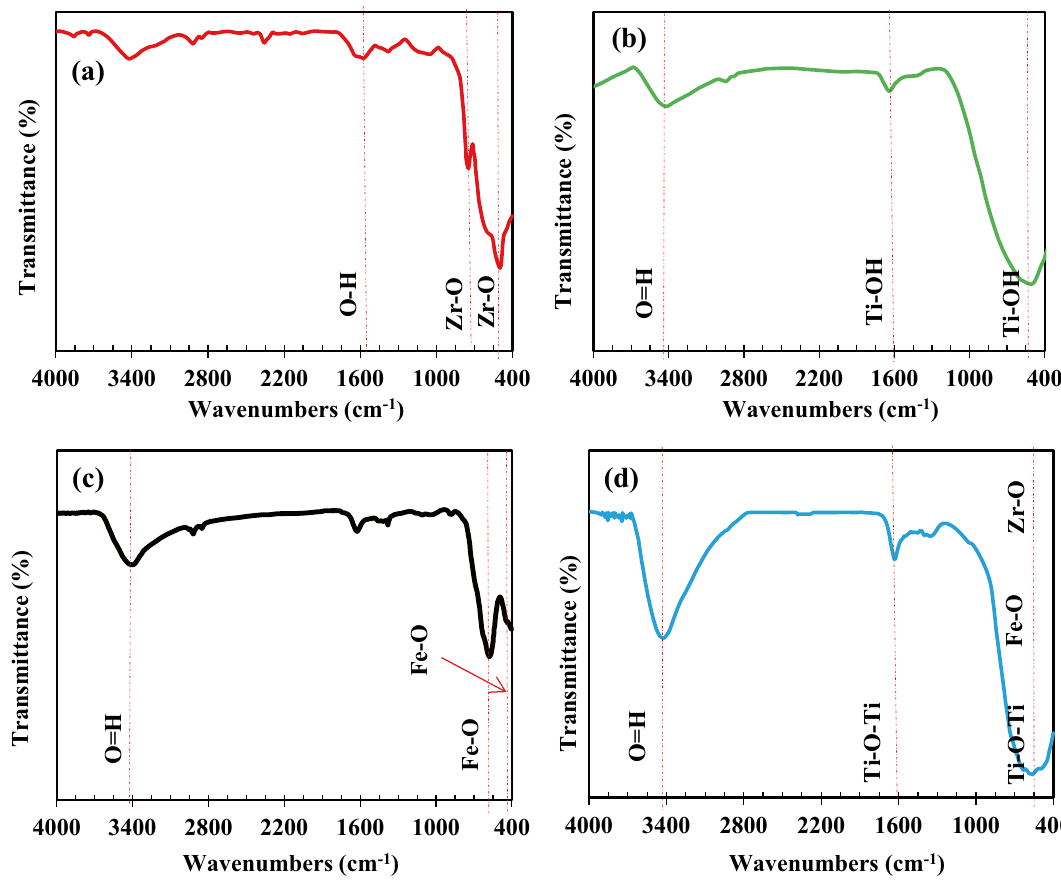
Figure 5. FTIR spectra of ( a ) ZrO 2 , ( b ) TiO 2 , ( c ) Fe 3 O 4 , ( d ) of ZrO 2 /TiO 2 /Fe 3 O 4 FTIR analysis. Figure 5a–d shows the FTIR analysis of ZrO 2 , TiO 2 , Fe 3 O 4 , and ZrO 2 /TiO 2 /Fe 3 O 4 photocata- lysts. As for ZrO 2 , the strong broad peak at 498–502 cm −1 region is attributed to the vibration mode of ZrO 2 − 3